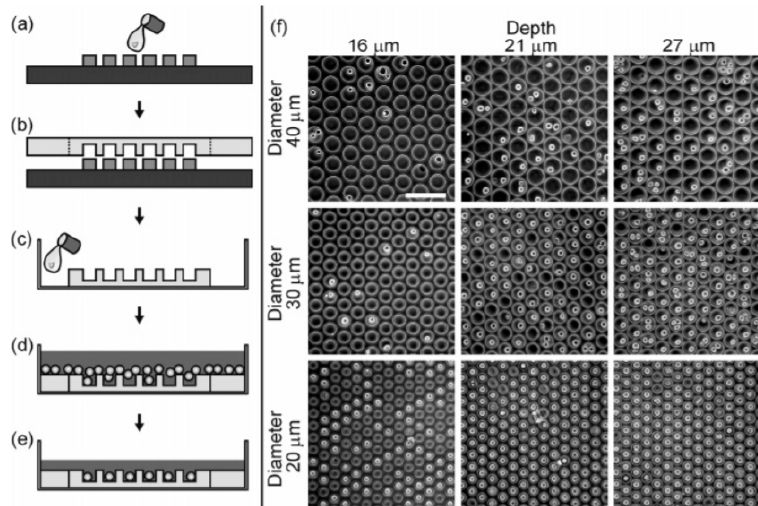
Figure 3. Cells trapped in polydimethylsiloxane (PDMS) microwells. ( a – e ) Fabrication and seeding procedures (photolithographied master and PDMS, peeling-off, PDMS wells peeled off and put at the bottom of a Petri dish, cells settlement into the peeled-off wells); ( f ) cells remaining in microwells, depending on their diameters and depths. Scale bar: 100 µm. Reprinted with permission from Retting et al. [43]. Copyright © 2005 American Chemical Society.